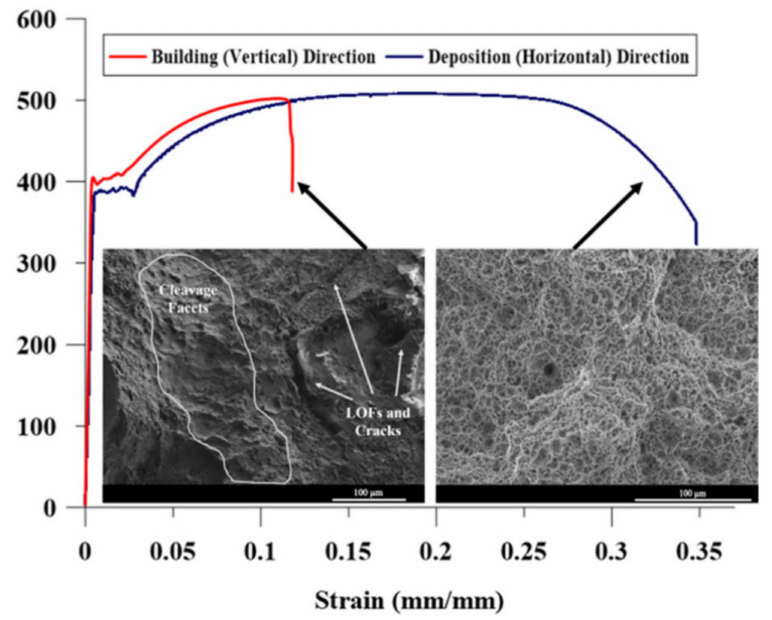
Figure 17. Stress–strain curve for WAAM ER70S